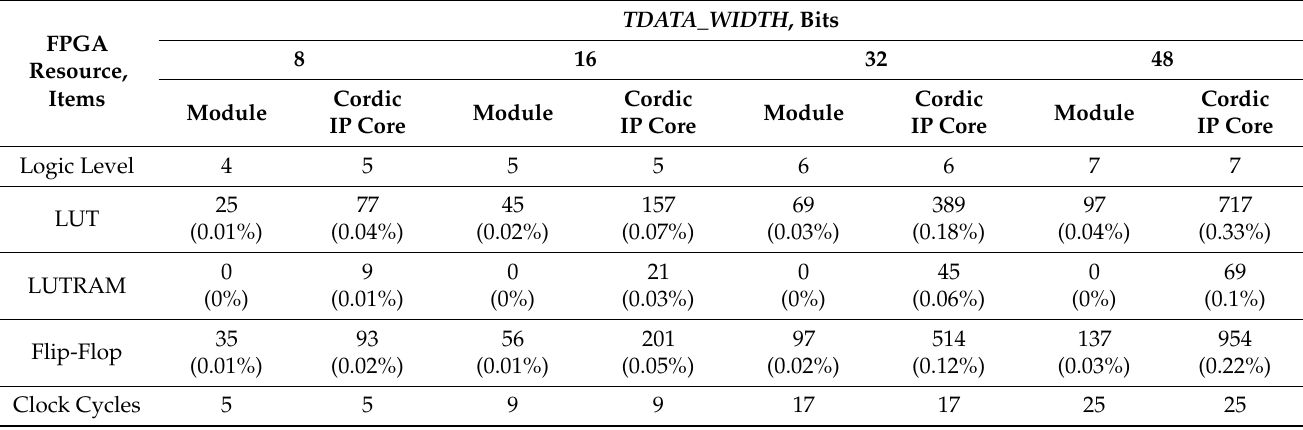
Table 1. The results of synthesis for the proposed module (sequential mode) and the Cordic IP core.